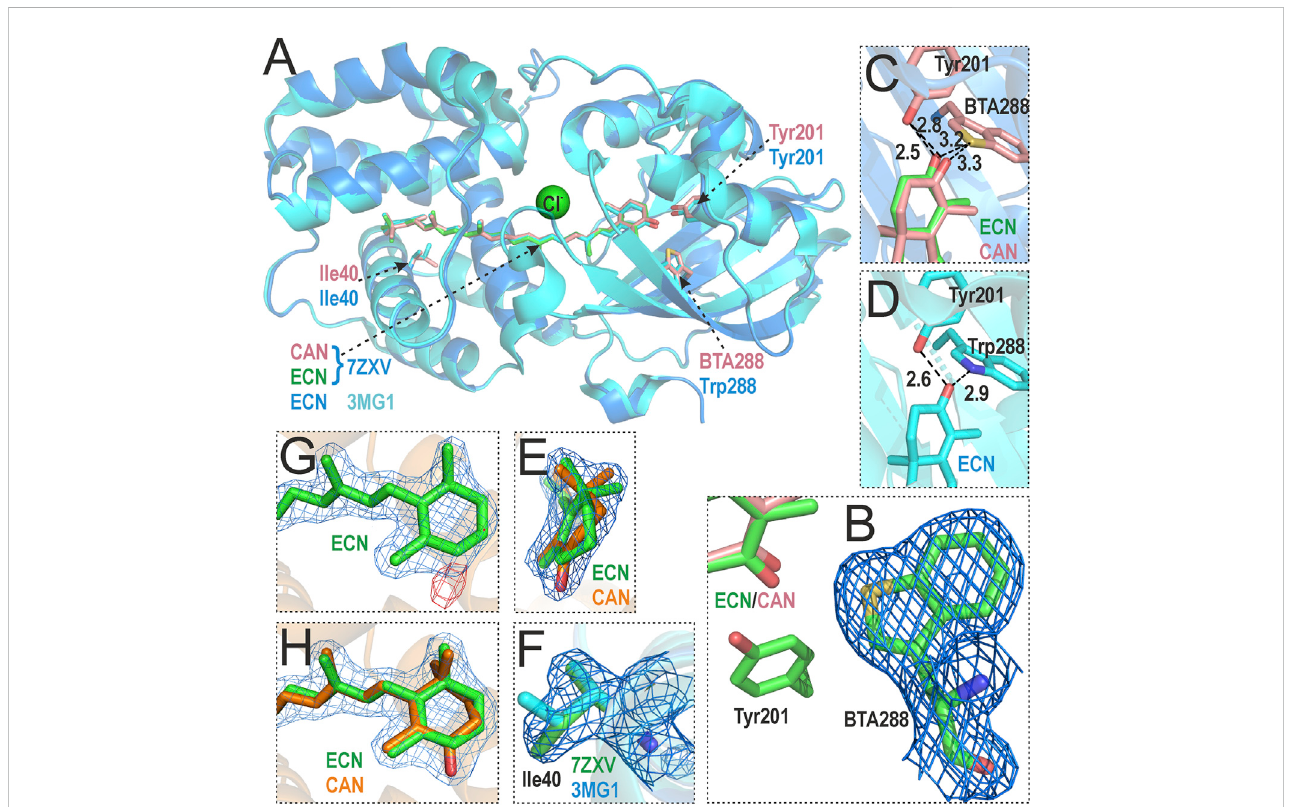
FIGURE 5 Crystal structure of the OCP-W288_BTA variant (PDB: 7ZXV) and comparison with wild-type Synechocystis OCP (PDB: 3MG1). (A) Overlay of OCP- W288_BTA (blue) and wild-type OCP (cyan) shows no global structural changes. Residues Tyr201, Trp/BTA288 and Ile40 are shown as ball-and-stick models (note the different colors of the C atoms: rose/orange/green in 7ZXV, and cyan in 3MG1). A Cl − ion discovered in the 7ZXV structure is shown in green. (B) Sigma-A-weighted 2 mFo - DFc electron density map around BTA288, re fl ecting the distinct ring geometry of the BTA side chain. (C,D) Cofactor coordination in detail for OCP-W288_BTA (C) and wild-type OCP (D) . The distance between BTA288 and the xanthophyllic cofactors increases only slightly from 2.9 Å to 3.2/3.3 Å compared to coordination by Trp288 in wild-type OCP, the distance between Tyr201 and ECN is comparable to wild-type OCP and slightly increased for CAN. (E) The 2 mFo-DFc electron density map is shown around the ECN/CAN end rings in the NTD to illustrate the different ring geometries corresponding to the sp 2 / sp 3 hybridization state of the carbonyl carbon atom in CAN/ECN. (F) The 2 mFo-DFc electron density map around Ile40 in 7ZXV shows a different rotamer state of the side chain (green) than in the 3MG1 structure (cyan). (G) The 2 mFo-DFc (blue) and Fo-Fc (red) electron density maps around the xanthophyll cofactor in OCP-W288_BTA, in which only ECN is fi tted, clearly show the difference electron density attributable to a missing keto oxygen atom (red). (H) The 2 mFo-DFc electron density map in which both ECN and CAN were fi tted showed occupancies of 45% and 55%, respectively, after re fi